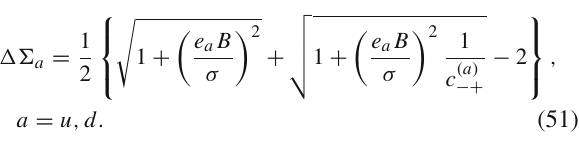
Fig. 3 The K − ( eB calculated with ECL (solid line) in comparison with the lattice data from [25] and chiral perturbation theory (dashed line)